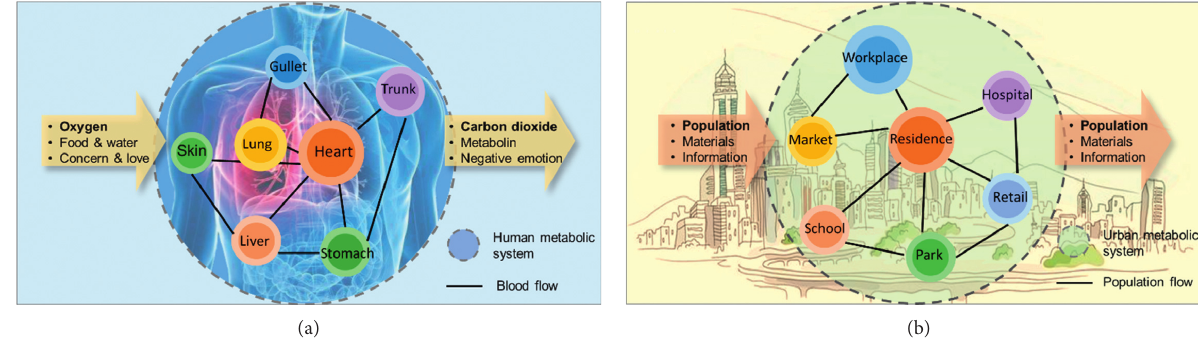
Figure 1: Schematic diagram of the human metabolic system and urban metabolic system. (a) Human metabolic system. (b) Urban metabolic